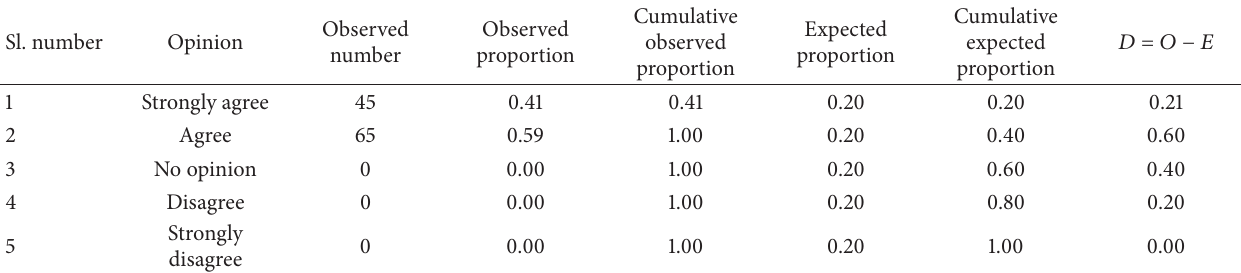
Table 11: Clearing the doubts of the account and loan details, KS Test. Sl. number